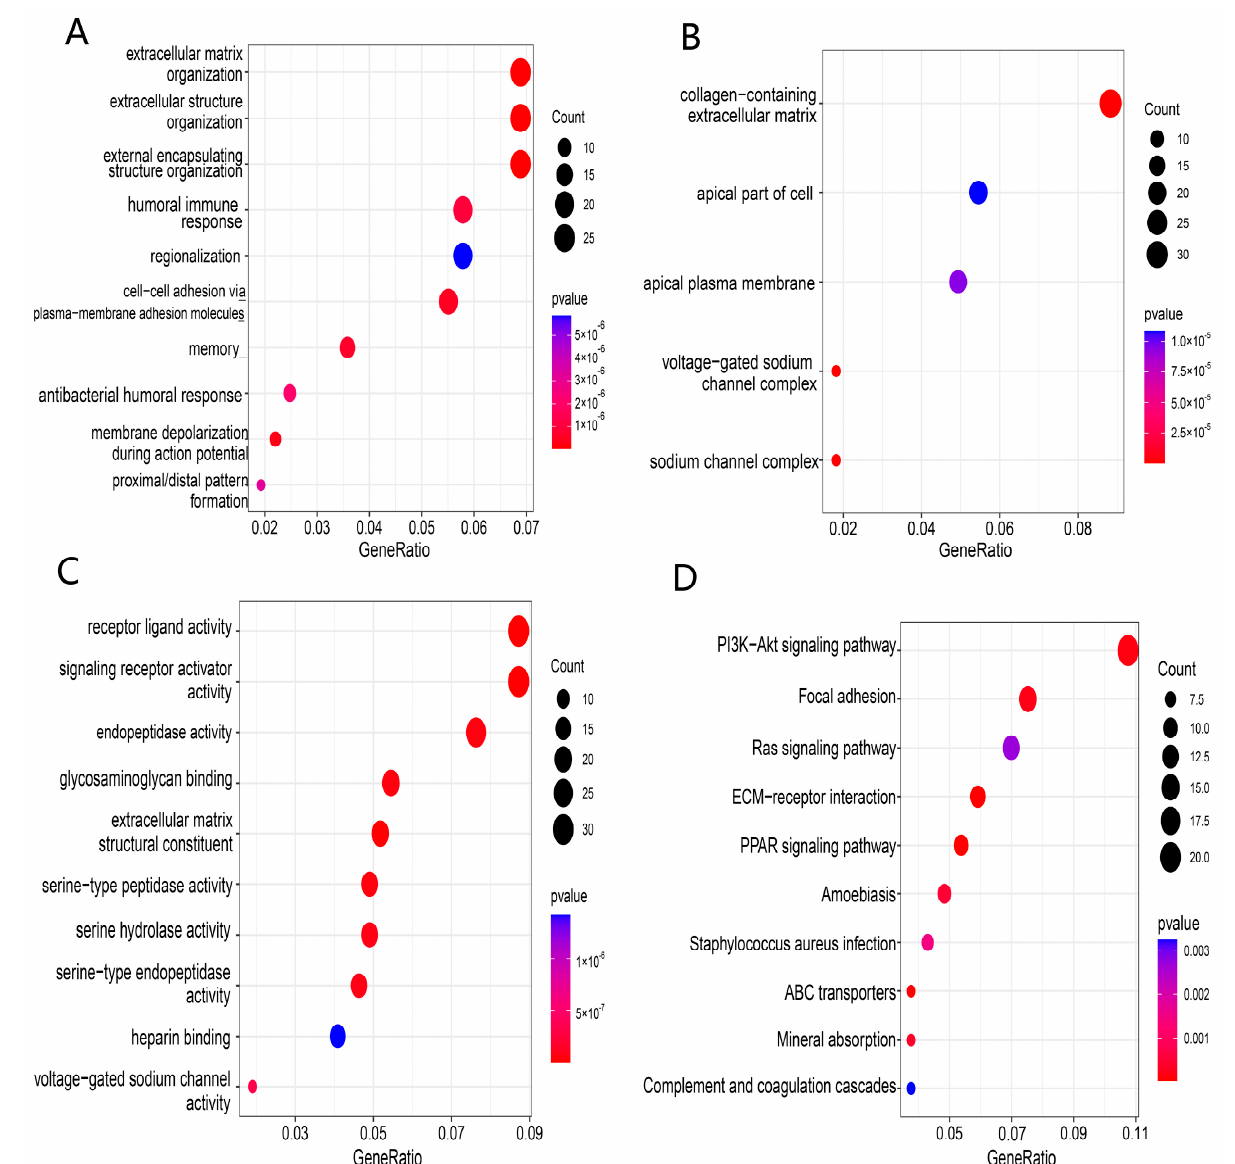
Figure 7. Functional enrichment analysis of TCGA-BRCA based on the risk model: ( A – C ) biological process (BP), cellular component (CC), and molecular function (MF) enrichment for the risk model; ( D ) KEGG pathway enrichment in the risk model.